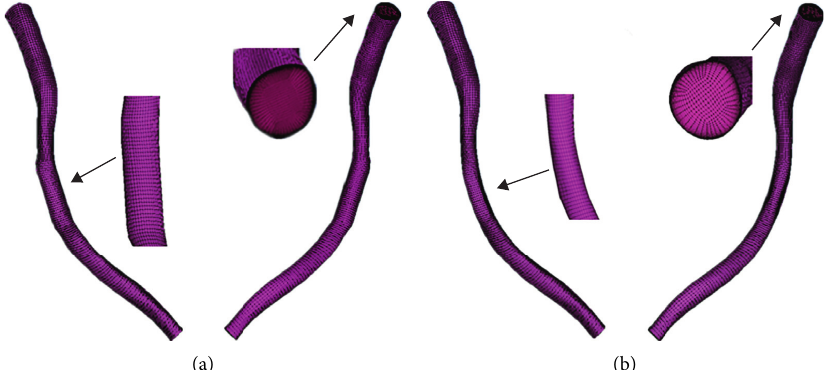
Figure 2: Mesh of the (a) straightening and (b) normal models.